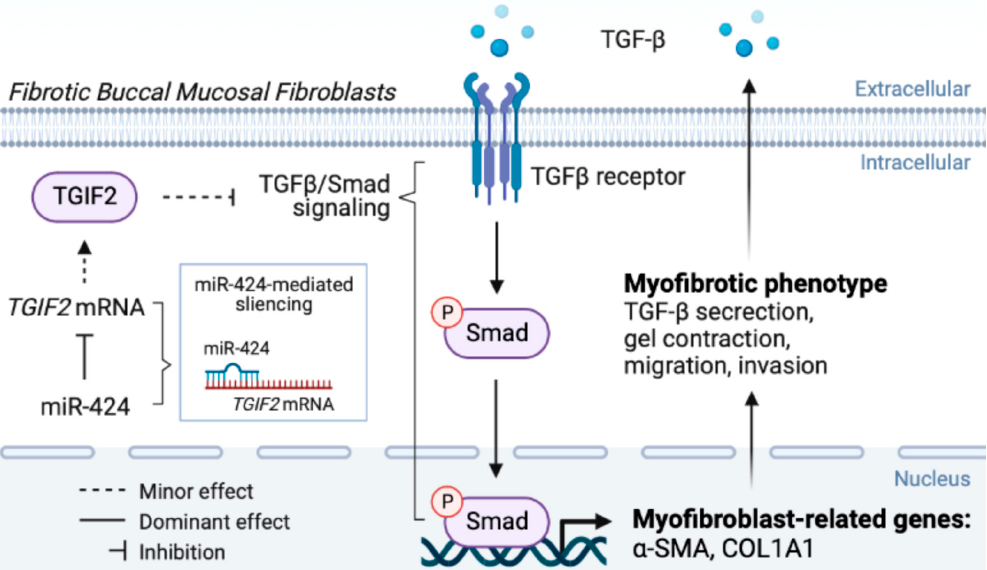
Figure 6. The graphic abstract of the present study illustrates the mechanisms of the miR-424/TGIF2 axis in the regulation of myofibroblast transdifferentiation in oral submucous fi- brosis